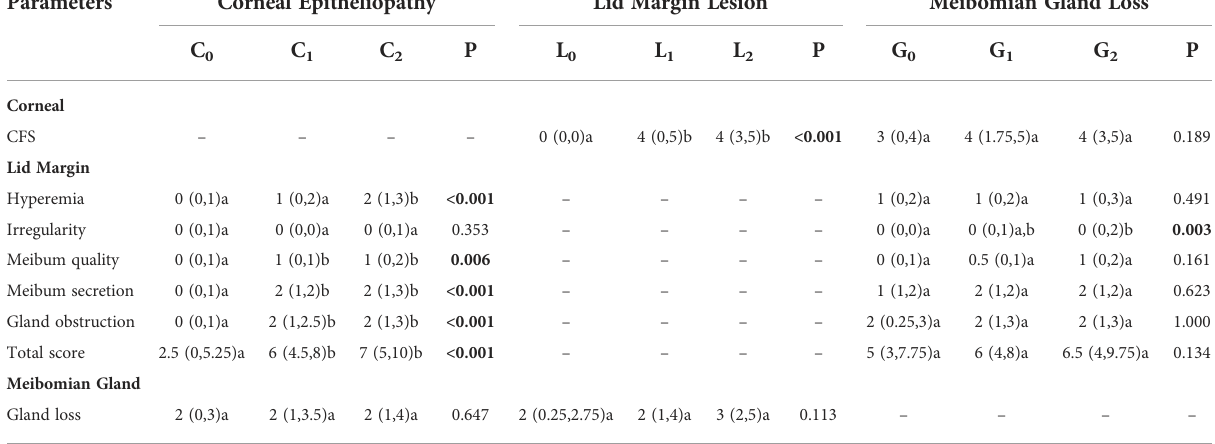
TABLE 4 Correlation among ocular surface